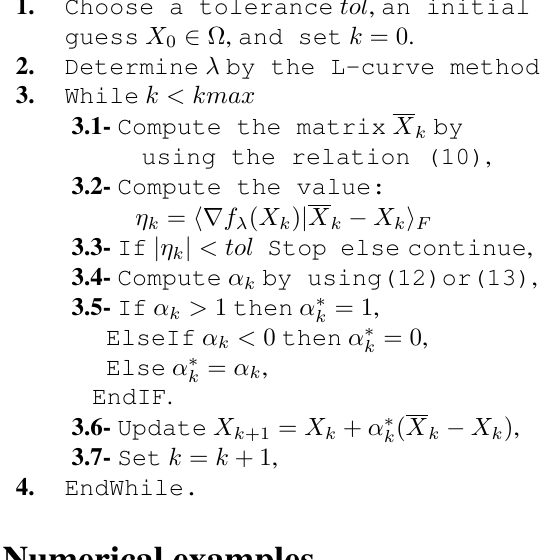
Table 1: PSNR for different values of the variance of the multiplicative and the additive